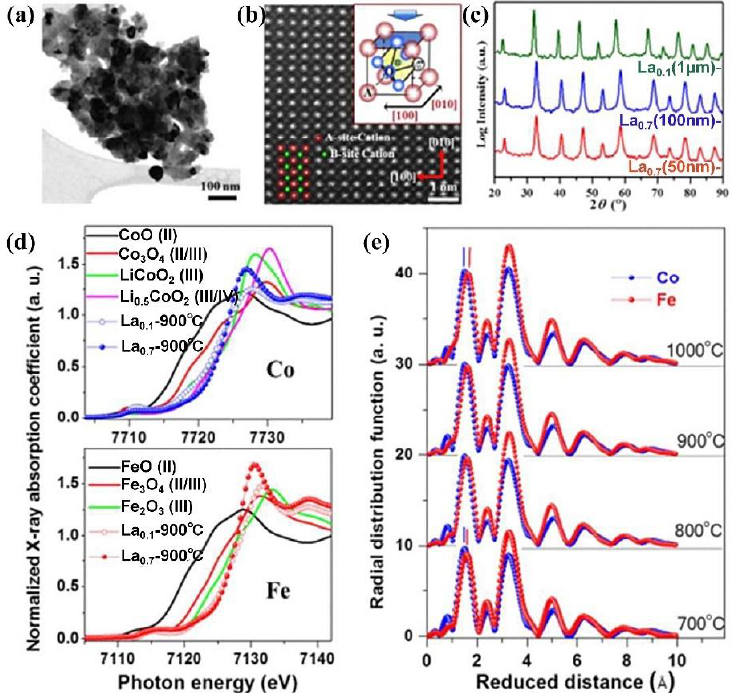
Figure 7. ( a ) BFTEM image of La 0.7 – 50 nm; ( b ) HAADF STEM image showing the atomic arrangements of cubic perovskite structure in {100} direction and schematic of a perovskite unit cell; ( c ) X-ray diffraction patterns for La 0.7 – 50 nm, La 0.7 – 100 nm and La 0.1 – 1 µm; ( d ) Normalized Co and Fe K-edge XANES spectra; ( e ) RDFs of Fourier-transformed k 3 -weighted EXAFS spectra [111]. Copyright 2015, the Royal Society of Chemistry.